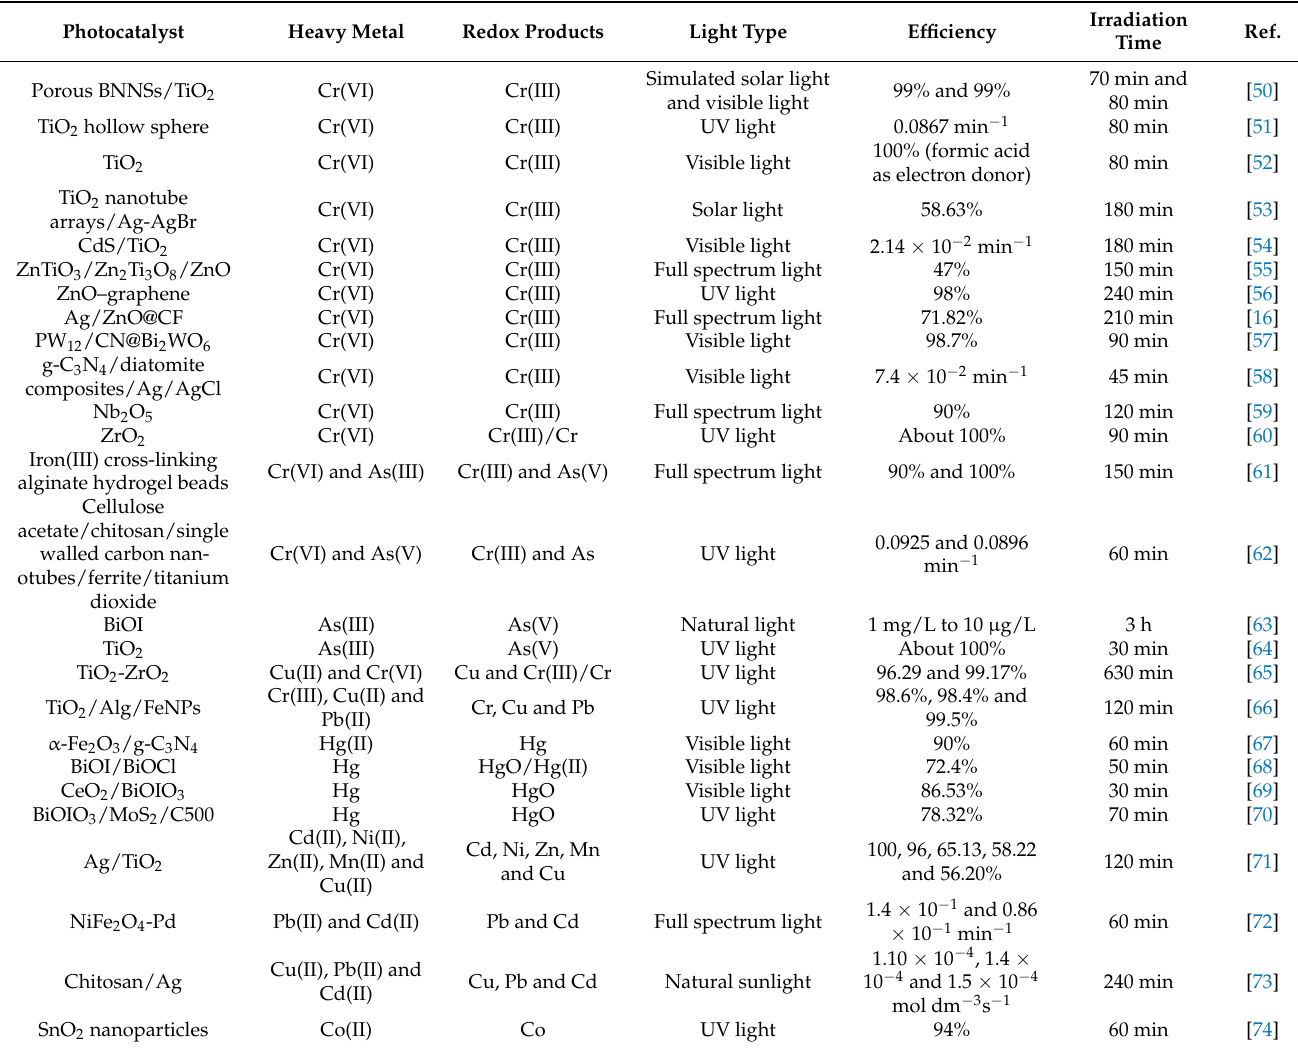
Table 3. Overview of applications of photocatalytic heavy metal